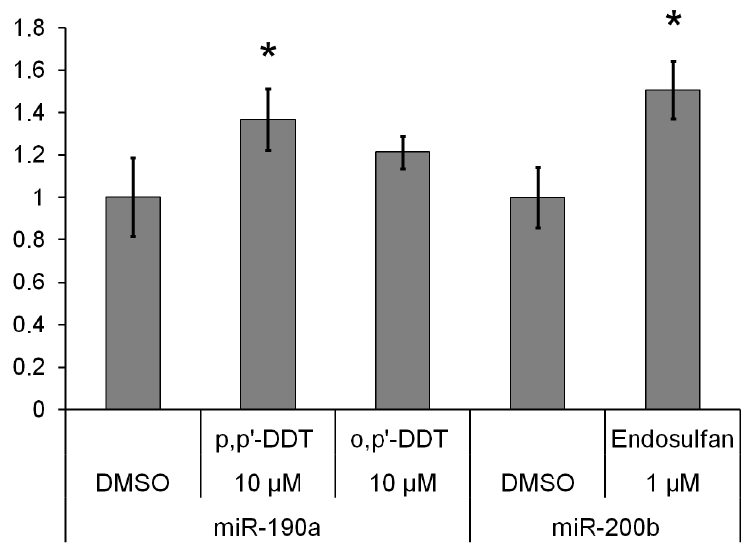
Figure 1. Changes in relative levels of miRNAs in MDA-MB-231 cells exposed to an insecticide for 48 h. The Y -axis shows the ratio of the miRNA level in the cells treated with a DDT isomer or endosulfan to the miRNA level in the cells treated with DMSO. Each value is the mean of three independent experiments. * Significant differences from the control ( p < 0.05).